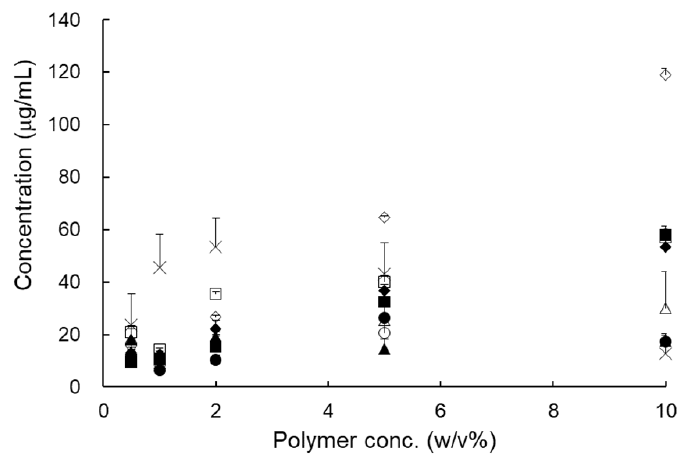
Figure 2. Solubility of RXB according to the aqueous polymer solution concentration ( n = 3, means ± SD). (Key: ■ : Gelucire ® 44/14, □ : Gelucire ® 50/13, ◆ : Solutol ® HS 15, ▲ : PEG 4000, △ : PEG 20000, ○ : PVP VA 64, ● : PVP K 90, ×: PVA, ◇ : Soluplus ® .